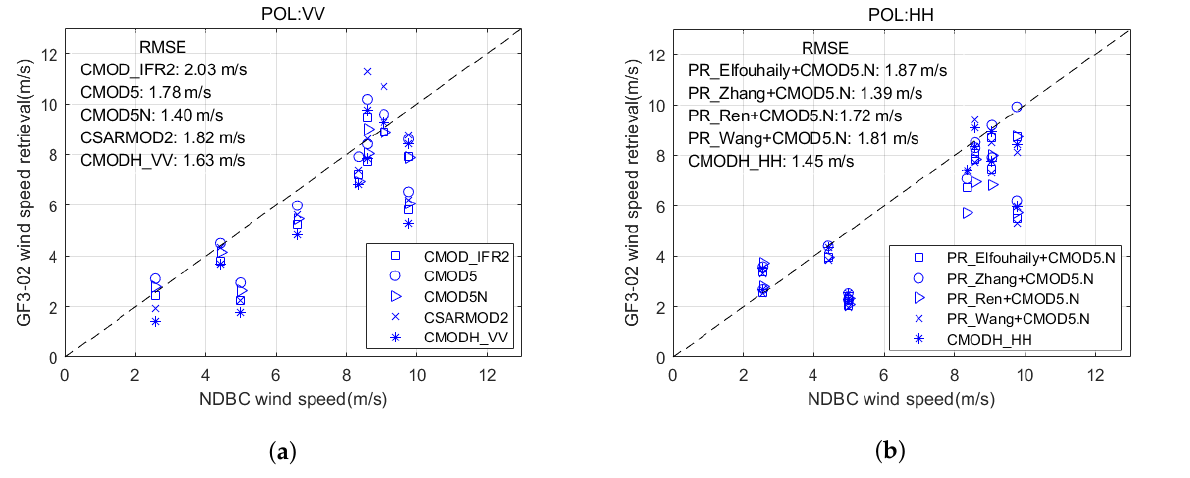
Figure 3. Comparison of wind speed retrieval results of the GF3-02 SAR data based on each GMF model and NDBC speed wind. ( a ) VV polarization; ( b ) HH polarization.